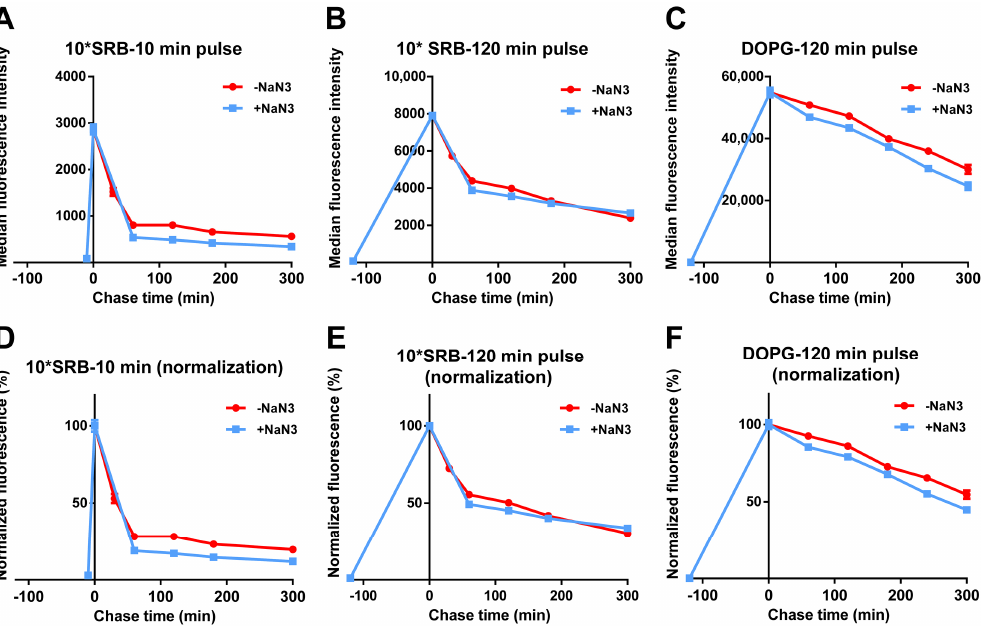
Figure 4. Release of free SRB and DOPG liposomes in energy-depleted cells. HeLa cells were exposed to ( A , B , D , E ) 50 µ M SRB (10*SRB) or ( C , F ) 62 µ g/mL DOPG liposomes in cMEM for ( A , D ) 10 min, or ( B , C , E , F ) 120 min (pulse), followed by removal of the extracellular liposome dispersion and further incubation in fresh cMEM without liposomes (chase) in cMEM without liposomes in standard conditions ( − NaN 3 ) or in the presence of 5 mg/mL NaN 3 (+NaN 3 ) to deplete cell energy. The length of the pulse in each experiment is indicated on the x axis as a negative time point (prior to the start of the chase). Cells were then collected at different chase times for flow cytometry analysis as described in Methods. The results are the average and standard deviation over 2 replicates of the median cell fluorescence intensity obtained by flow cytometry. In ( D – F ), the same data are shown after normalization for the fluorescence at 0 h chase. The data obtained from cells exposed to SRB in cMEM in standard condition ( − NaN 3 ) are reproduced from Figure